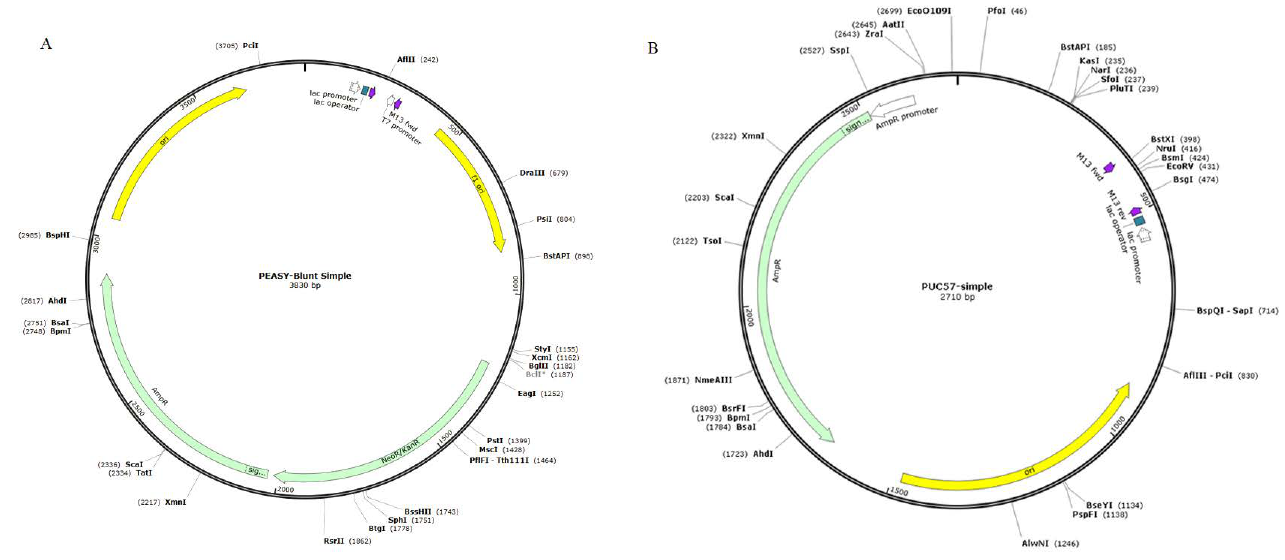
Figure 1. Schematic diagram of plasmid vectors. ( A ) pEASY. ( B ) pUC57.